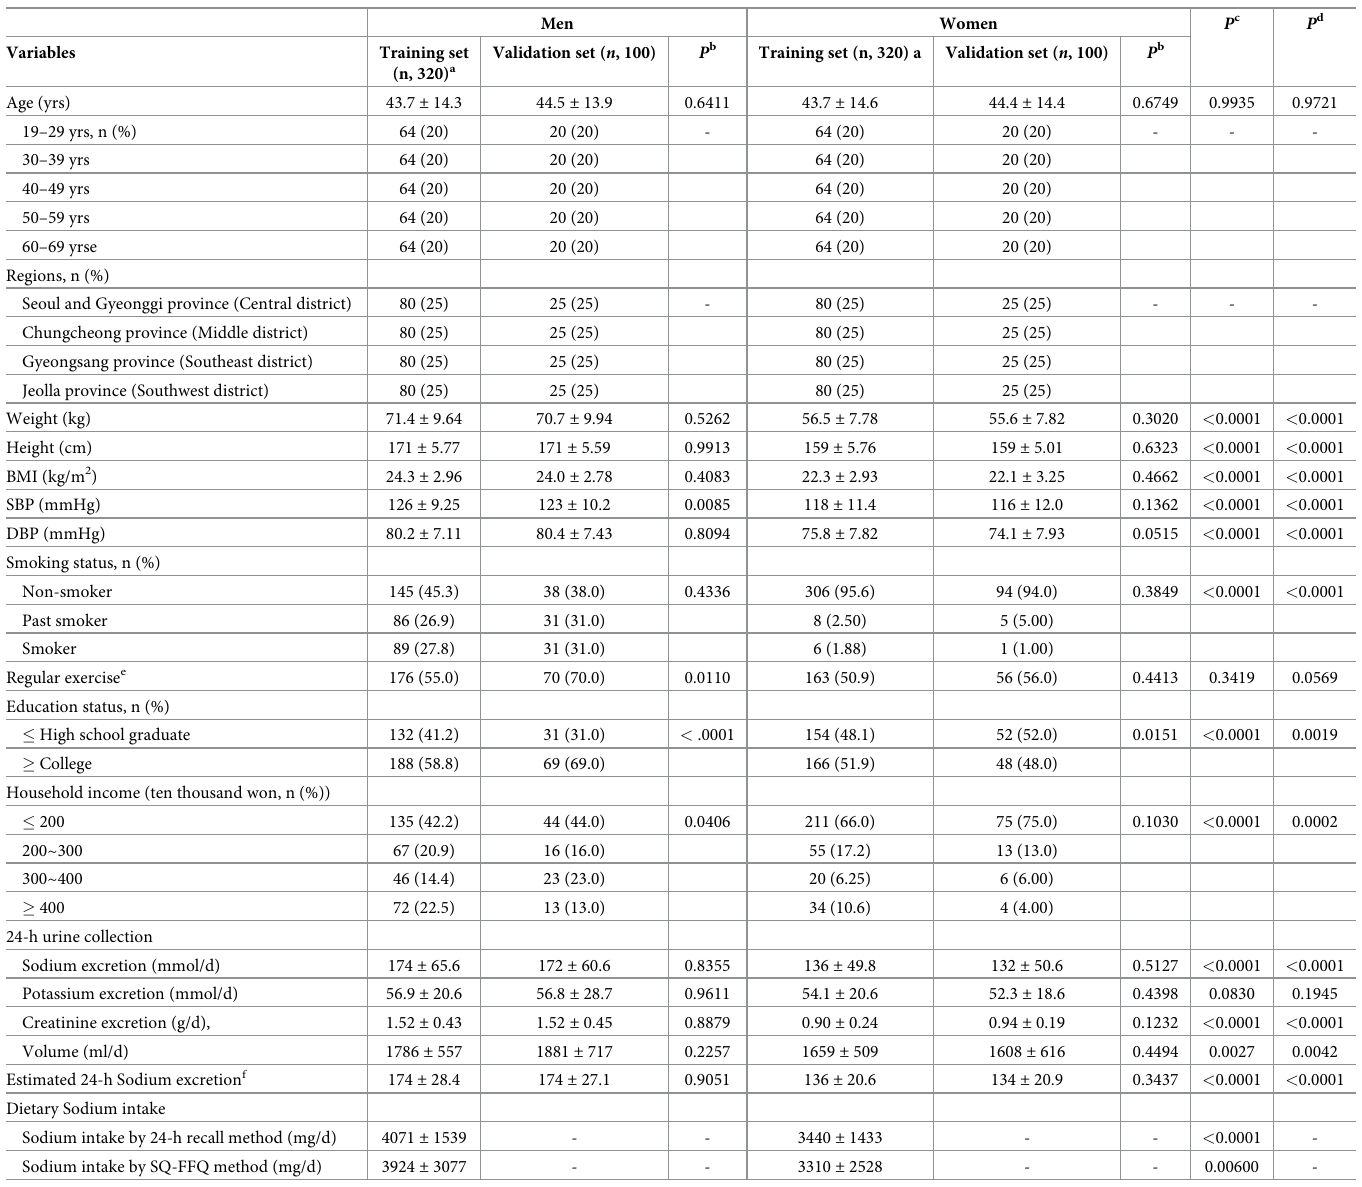
Table 1. General characteristics of study